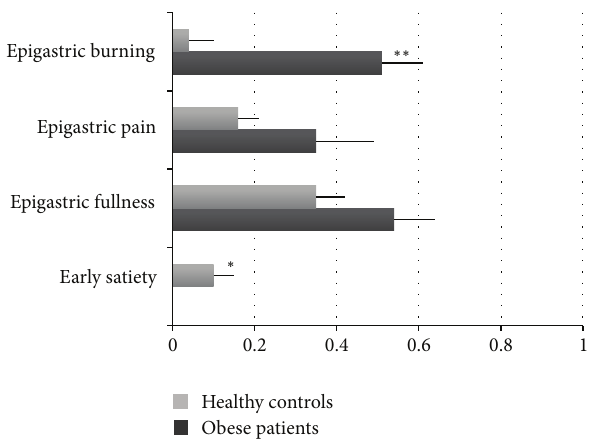
Figure 1: This figure shows the frequency-intensity scores (M ± SE) of the 4 cardinal symptoms: early satiation, epigastric fullness, epi- gastric pain, and epigastric burning in the studied obese population and